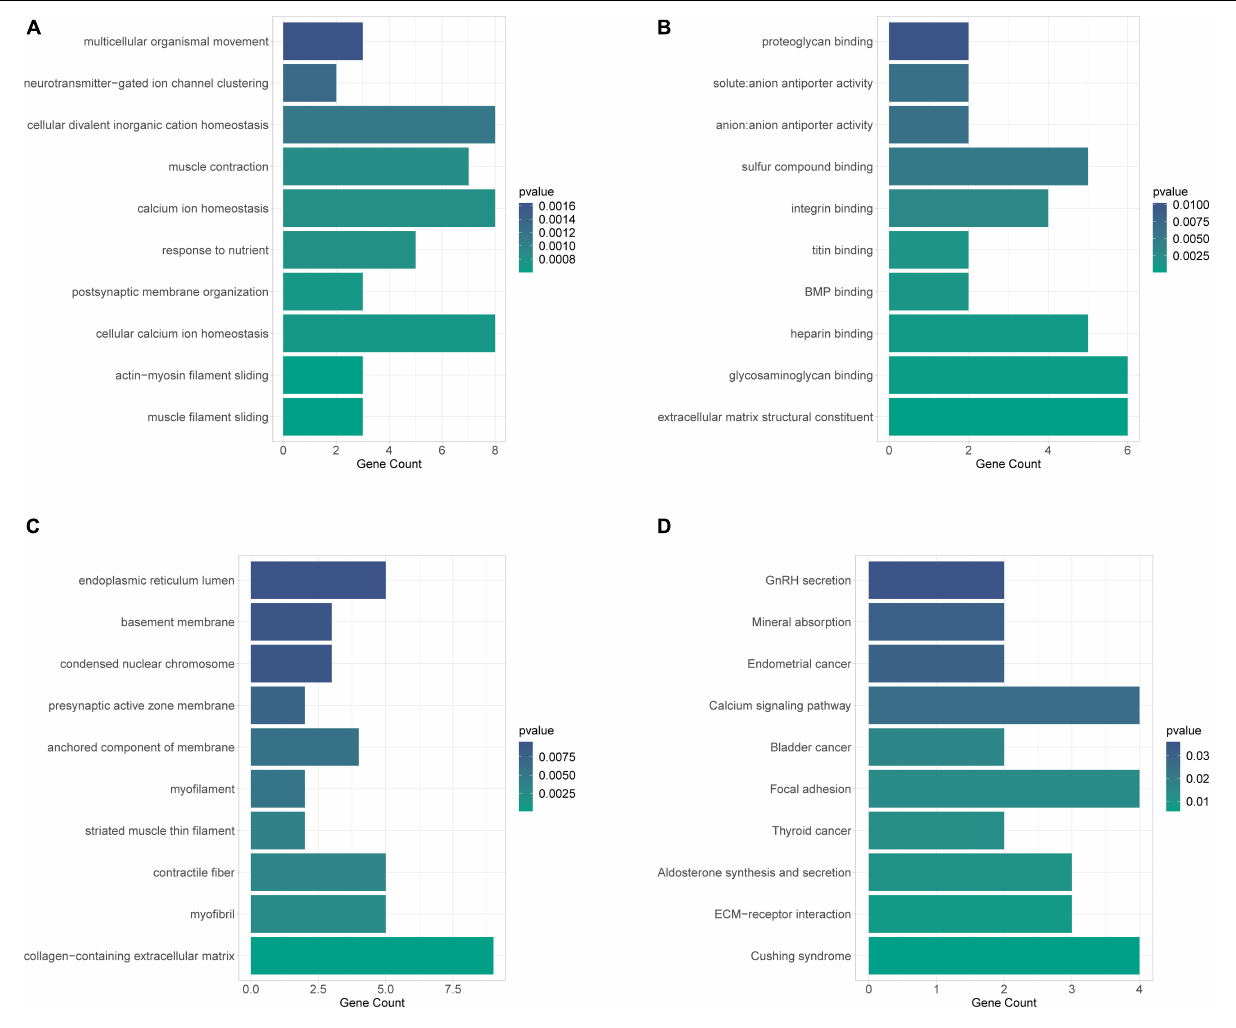
regulate the expression of 47 mRNAs with hsa-miR-223.